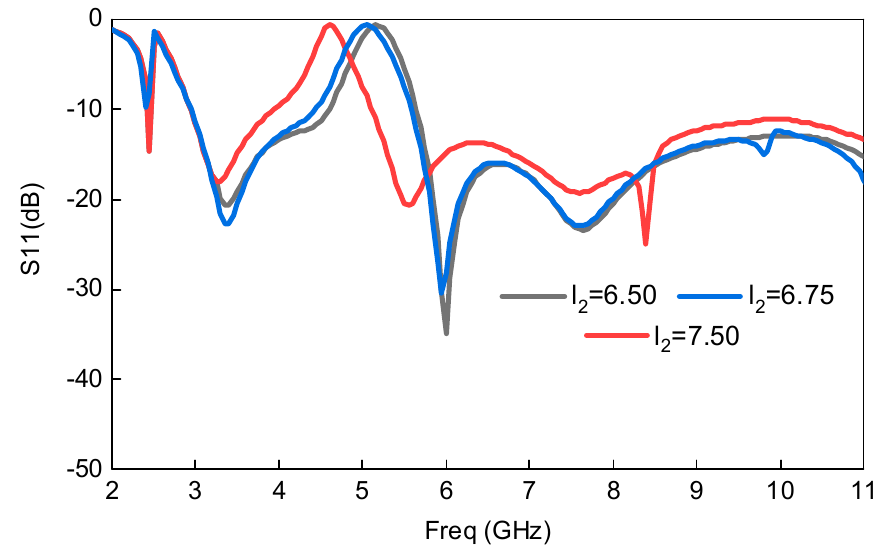
Figure 5. The reflection coefficient of the UWB antenna that included an integrated resonator with Cap variation from 0.1 pF to 0.5 pF.